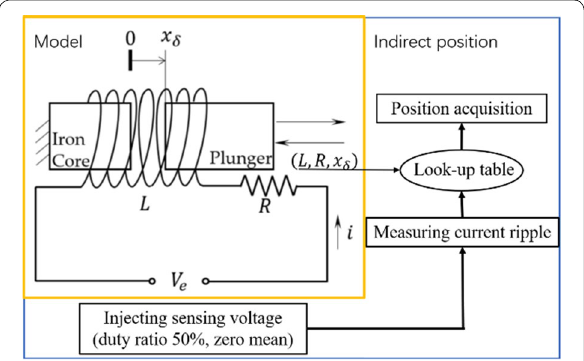
Figure 3 Schematic of the valve’s solenoid and indirect position acquisition